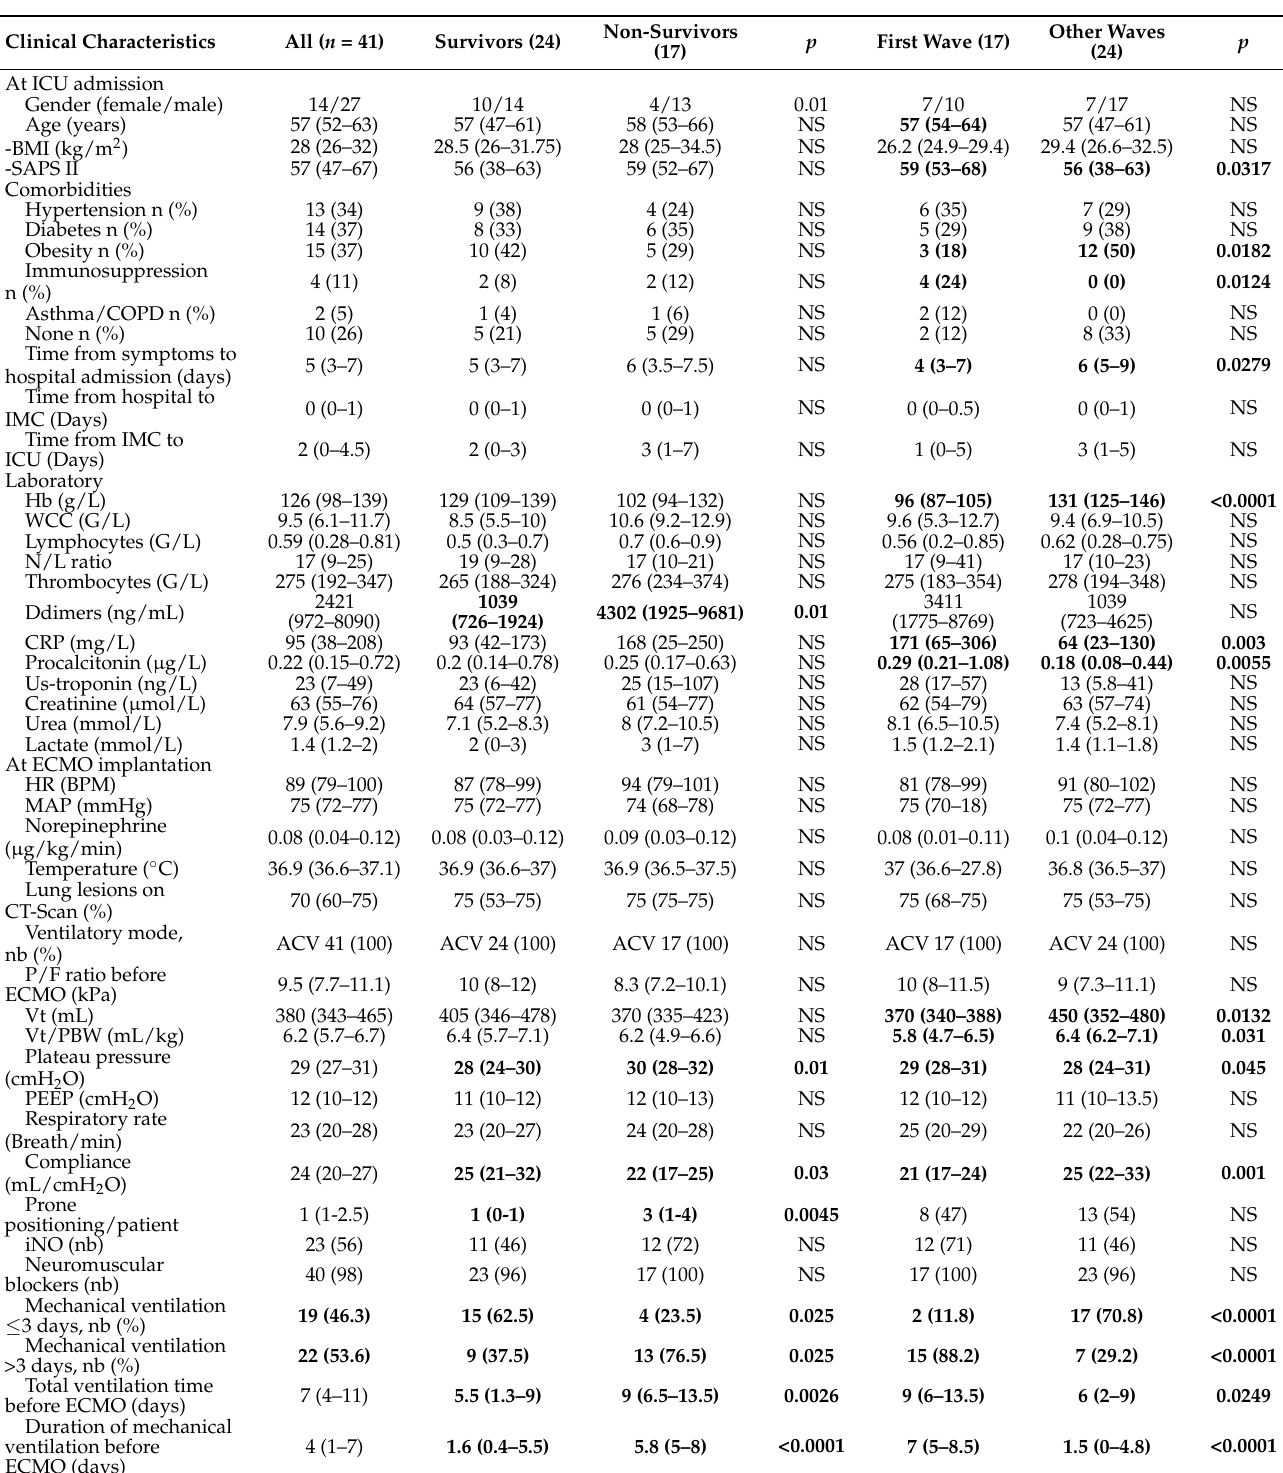
Table 1. Overall demographic, clinical, biological, hemodynamic, and mechanical ventilation charac- teristics before and on ECMO according to 90-day survival status and depending on the wave vs. other